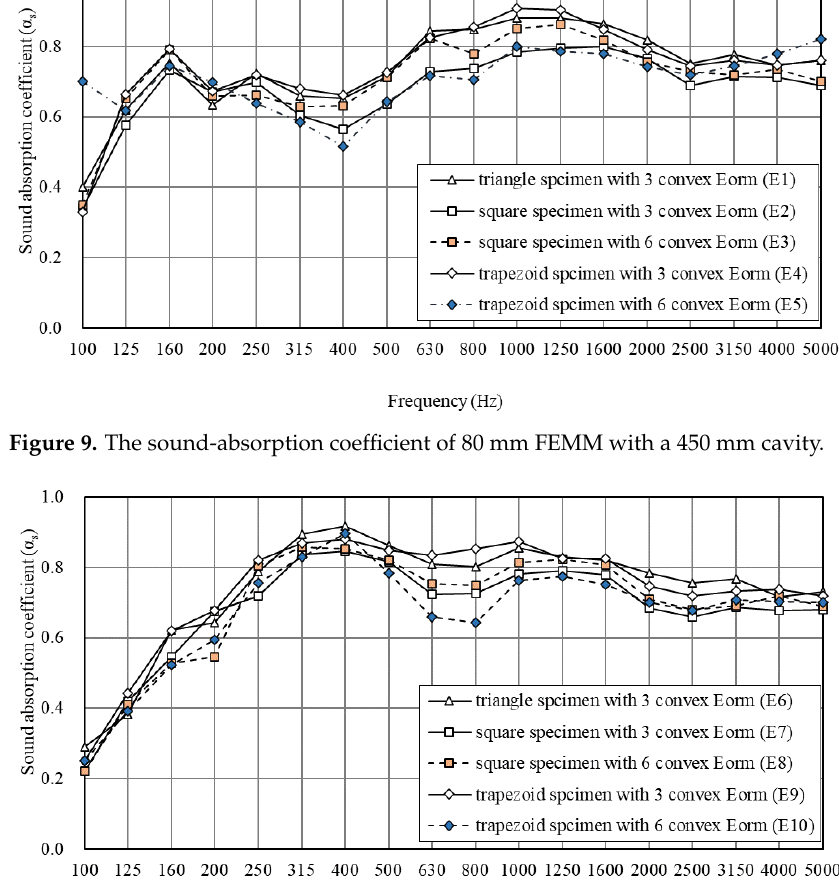
Figure 11. The sound-absorption coefficient of 30 mm FEMM with a 450 mm cavity. Figure 12. The sound-absorption coefficient of 30 mm FEMM with a 200 mm cavity.